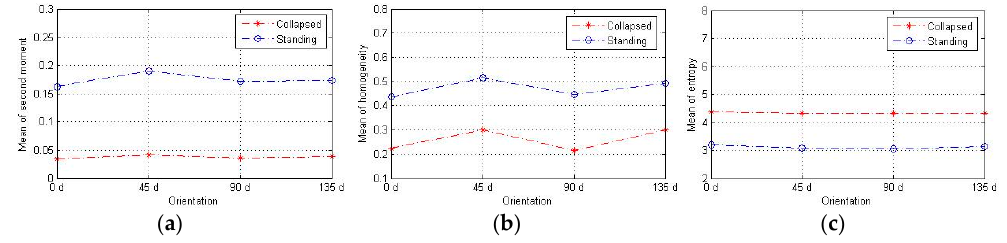
Figure 14. GLCM features with different orientations. ( a ) Mean of second moment; ( b ) Mean of homogeneity; ( c ) Mean of entropy.